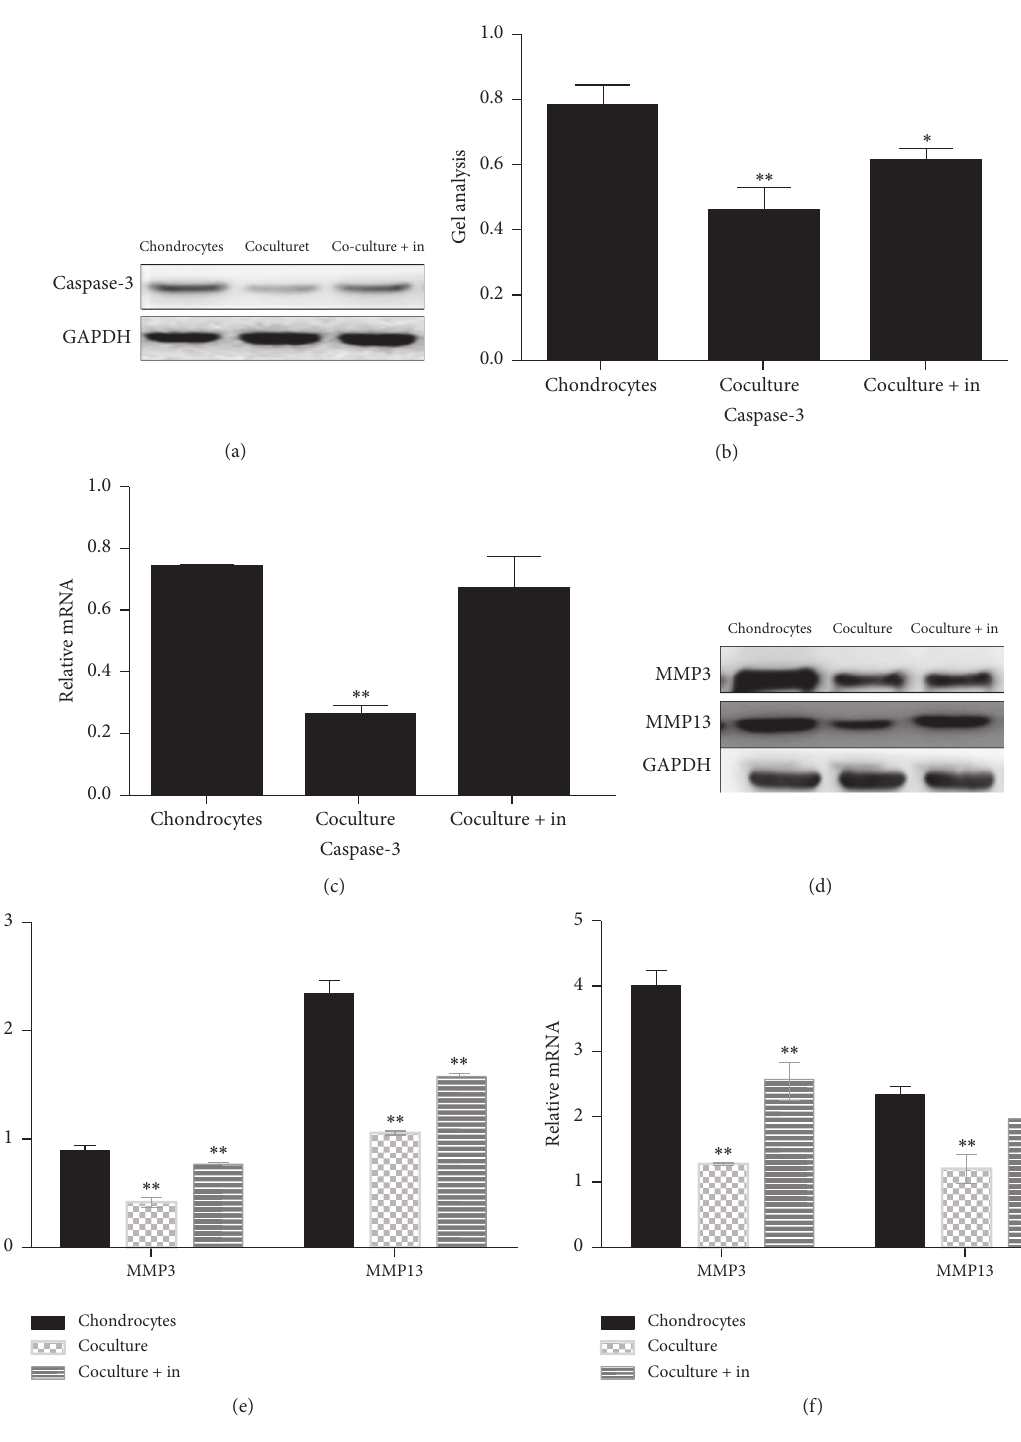
Figure 11: Effect of TGF- 𝛽 1 inhibitor on the expression of catabolic proteins and genes on chondrocytes cultured in different conditions for 5 days determined by western blot ((a), (b), (d), and (e)) and real-time PCR ((c), (f)). Both western blot and real-time PCR showed that some catabolic marker proteins and genes such as caspase-3, MMP3, and MMP13 were downregulated in chondrocytes when they were cultured with ADSCs coculture system and recovered back to the original levels when TGF- 𝛽 1 inhibitor was added in chondrocytes cocultured with ADSCs as tested by western blot ((a), (b), (d), and (e)) and real-time PCR ((c), (f)). Data are shown as mean ± SEM. ∗∗ 𝑝 < 0.01 versus control group. ∗ means 𝑝 < 0.05 versus